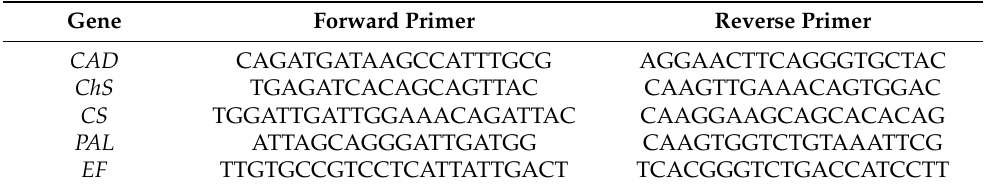
Table 1. Primers used for qPCR assays to amplify the chorismate synthase ( CS ), phenylalanine ammonia-lyase ( PAL ), NADPH-dependent cinnamyl alcohol dehydrogenase ( CAD 1), and chalcone synthase ( ChS ) genes. Elongation factor (EF) was used as reference gene. Gene Forward Primer Reverse Primer CAD CAGATGATAAGCCATTTGCG AGGAACTTCAGGGTGCTAC ChS TGAGATCACAGCAGTTAC CAAGTTGAAACAGTGGAC CS TGGATTGATTGGAAACAGATTAC CAAGGAAGCAGCACACAG PAL ATTAGCAGGGATTGATGG CAAGTGGTCTGTAAATTCG EF TTGTGCCGTCCTCATTATTGACT